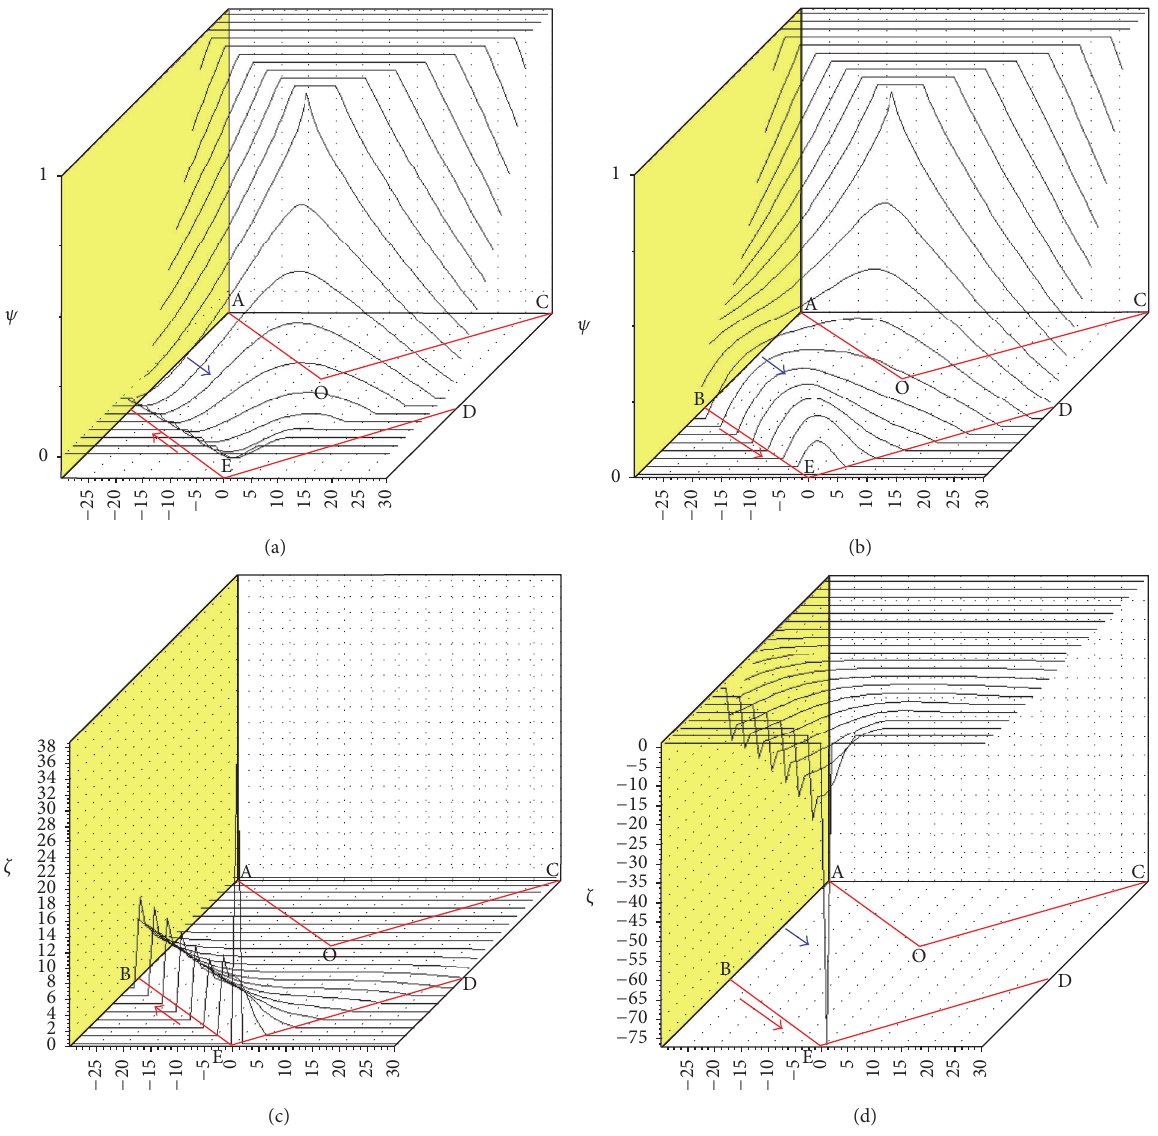
Figure 7: CFD-derived diagrams for the dimensionless flow function 𝜓 (a, b) and for the dimensionless curl function 𝜁 (c, d) for a Segal die with channel intersection angles ∠ (AOC) = 2 𝜃 = 105 ∘ , where inlet die wall BE moves upstream towards the punching direction with velocity = −𝑈 𝑉 𝑤 0 (a, c), inlet die wall BE moves downstream stream-wise with increased velocity dimensional transition times are 1.258 s (a, c) and 1.797 s (b,